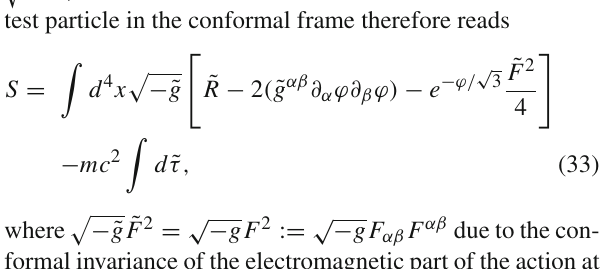
Fig. 6 Values of the parameters α and β in Eqs. (23–26) with respect to the density of the compact object for L m =